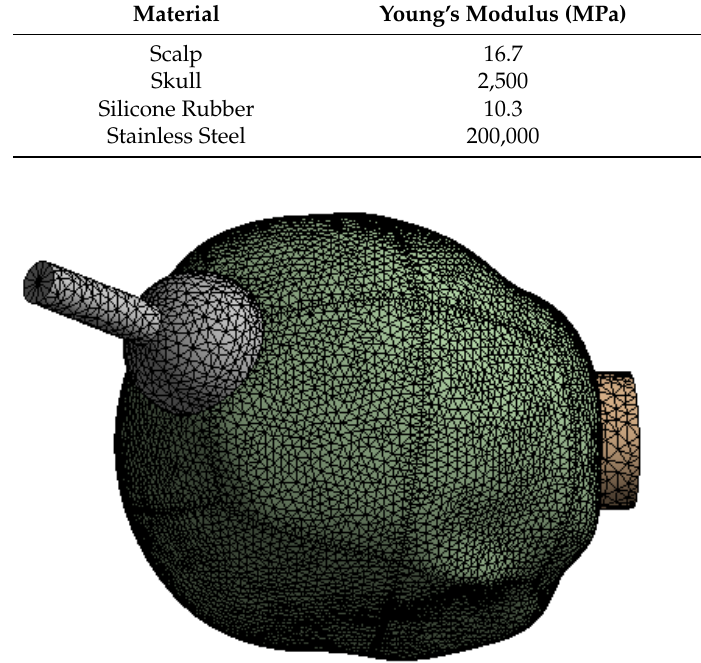
Figure 4. Mesh model, which is the finite element analysis model used herein. Table 1. Material properties setting in this study [15–17].